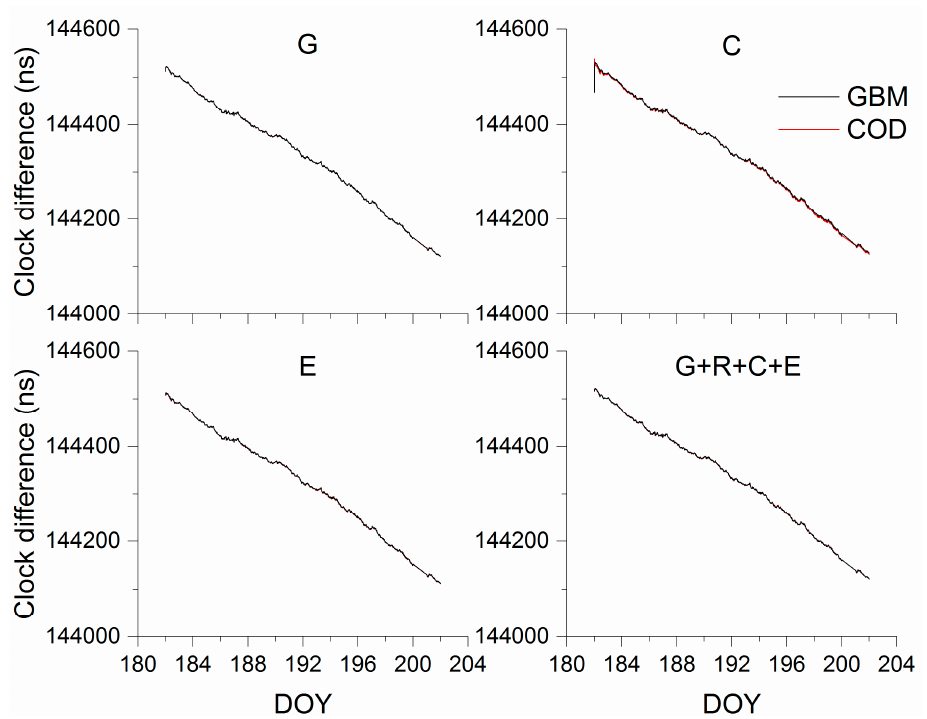
Figure 5. The clock difference in single-system and multi-GNSS models on HARB and NTSC using GBM and COD products.